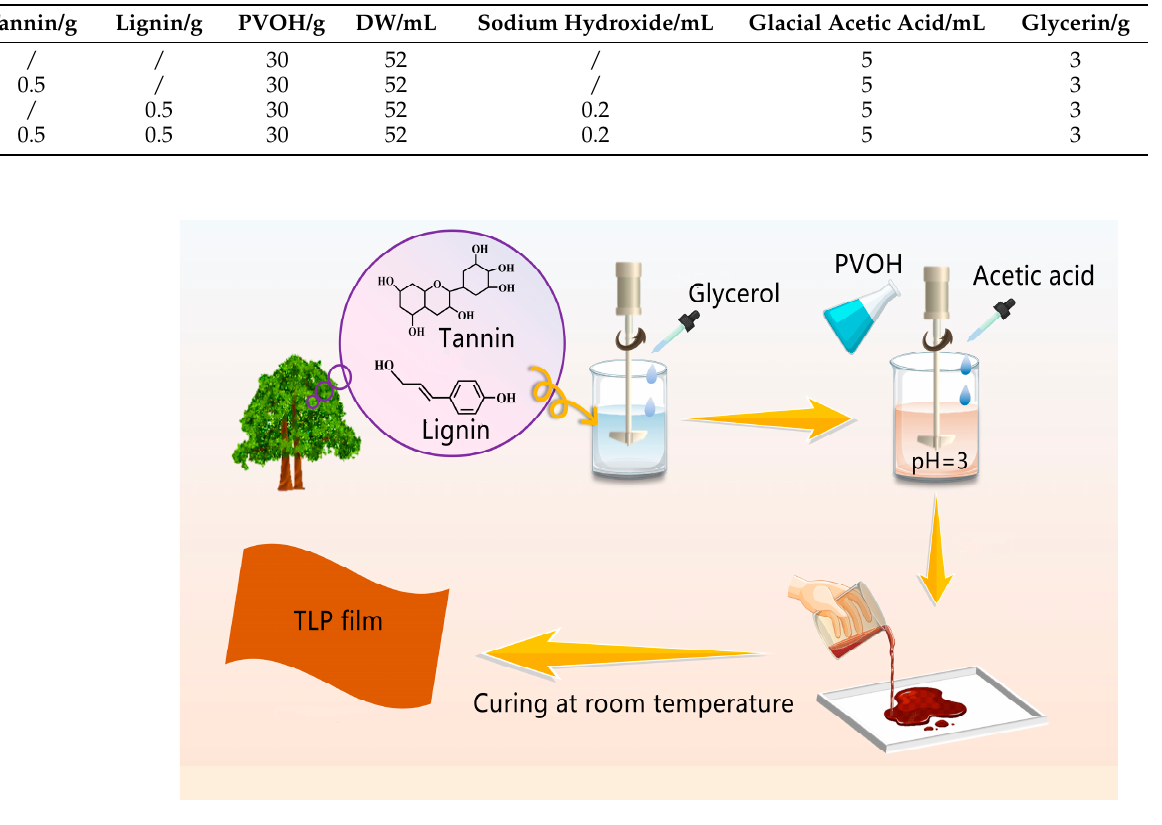
Table 1. Formulations incorporated in film preparations.